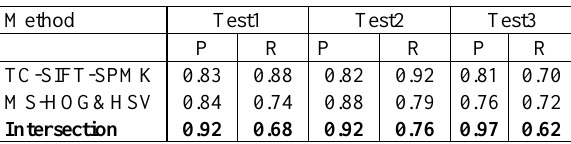
Table 4. Accuracy of intersection